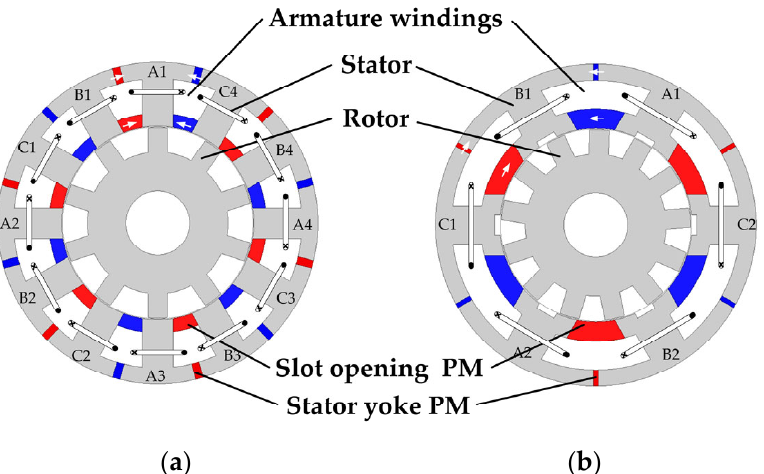
Figure 1. Cross ‐ section perspective of the HE ‐ DSDPM with: ( a ) conventional and ( b ) multi ‐ tooth Figure 1. Cross-section perspective of the HE-DSDPM with: ( a ) conventional and ( b ) multi-tooth structures.